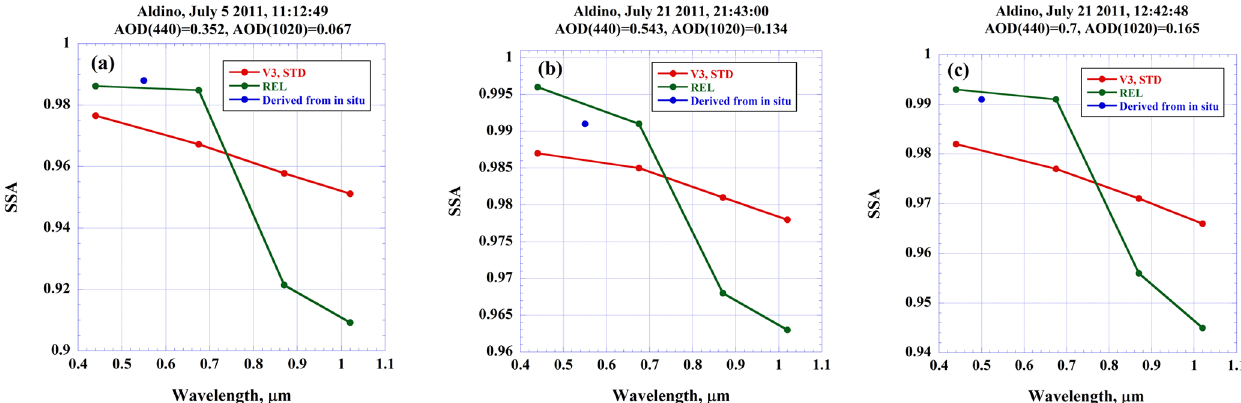
Figure 10. Comparison of SSA retrieved by V3 aerosol inversion code employing the STD assumption on IPRI smoothness constraints and SSA retrieved by inversion code using the REL assumption on SSA derived from in situ measurements at Aldino AERONET site: (a) 440nm AOD = 0.352, (b) 440nm AOD = 0.543 and (c) 440nm AOD = 0.7.